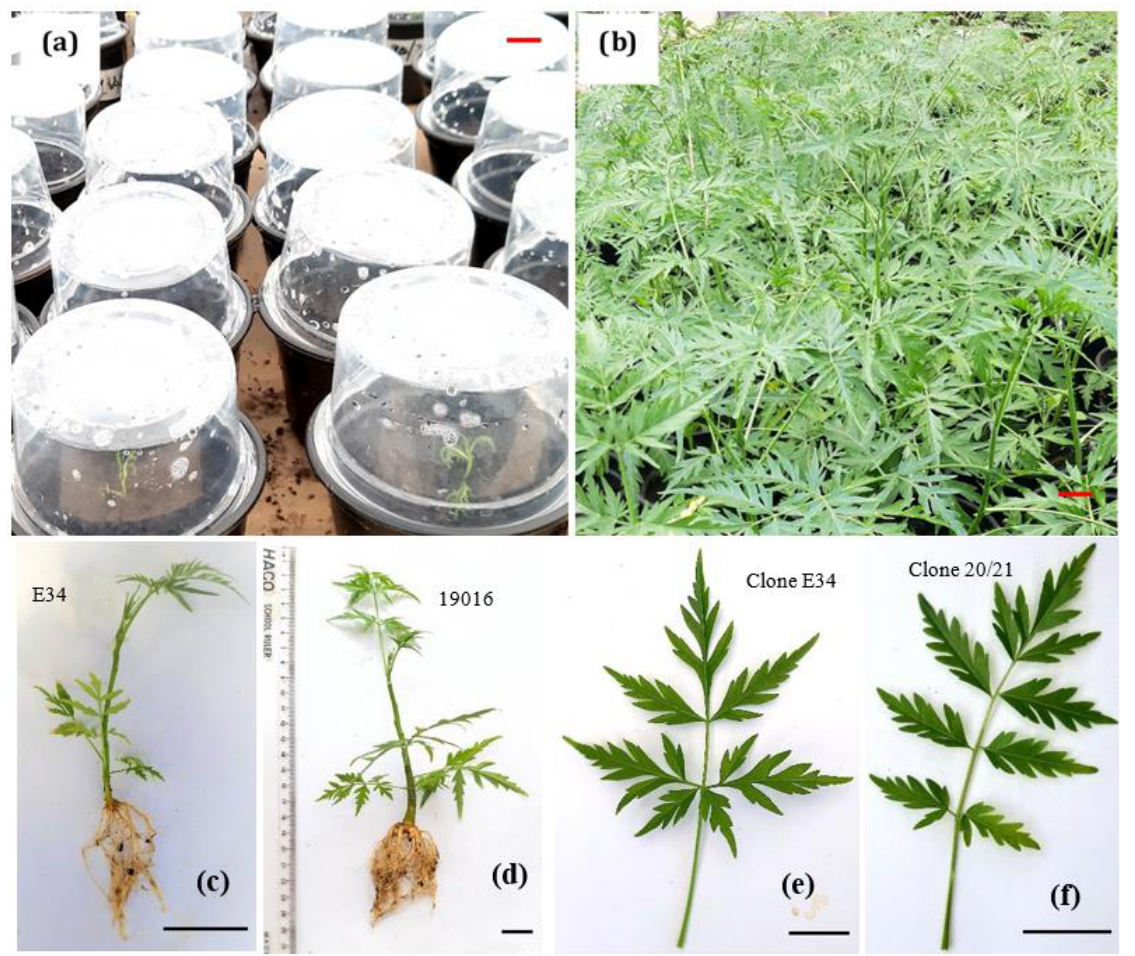
Figure 1. Acclimatization of in vitro propagated M. volkensii Gürke clones. ( a ) Covered